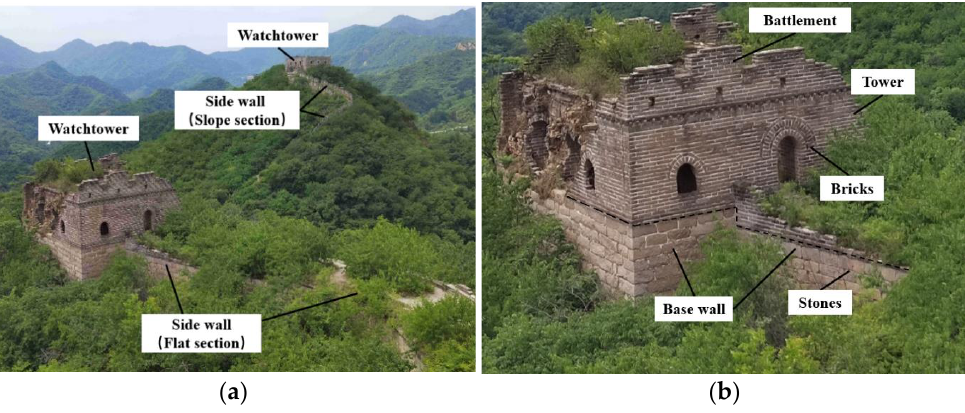
Figure 1. Photos and elements of the Great Wall: ( a ) Long shot; ( b ) Close shot. The base walls include three layers in horizontal section, stone layer, rubble layer, and mixed layer, as in Figure 3. The outer surface of each stone is chiseled into a regular rectangle with a dimension of about 1.06 m × 0.32 m × 0.17 m, making the Great Wall look like fine ashlar. However, the stones’ invisible surfaces remained uncarved, especially the left-hand side closer to the rubble layer (Figure 3). The external layer of stones is cemented by excellent mortar, and the middle layer rubbles are paved regularly by mid-level mortars mixed with gravels, while the interior layer is still dominated by rubbles, which are chaotic and mixed with earth, gravels, and rocks (Figure